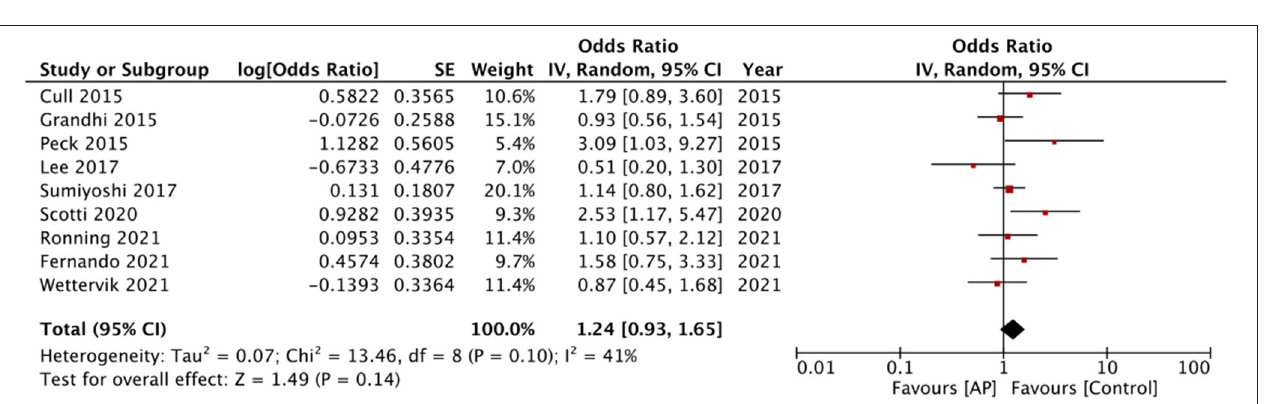
FIGURE 2 | Meta-analysis of crude early mortality rates between antiplatelet users vs. controls.